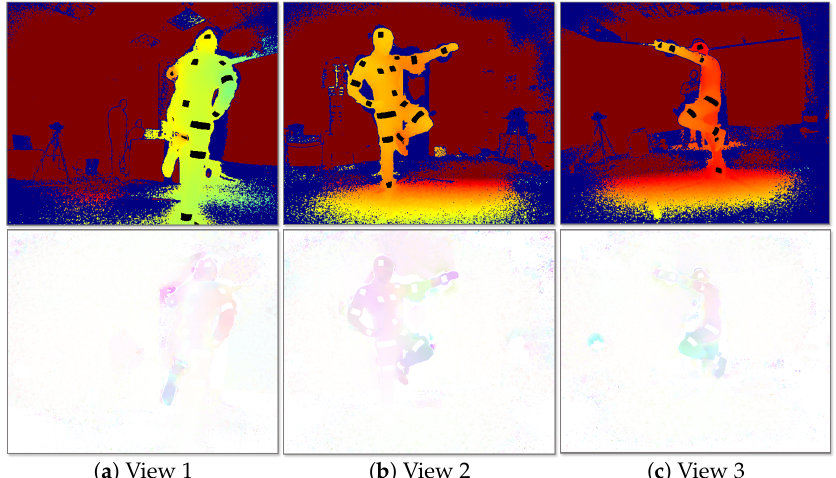
Figure 4. Multiview two-stream input. ( Up ) Colorized depth, mask subtracted. ( Down ) Colorized 3D optical